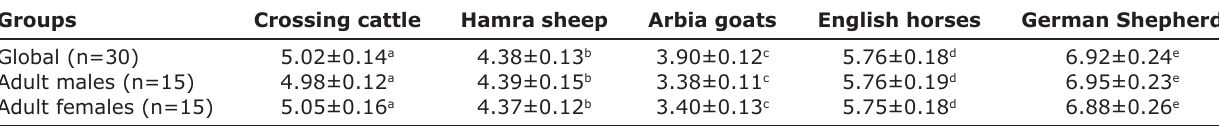
Table-4: Influence of red blood cells diameter on the species determination of pets (Group 2, expressed in μ m). Groups